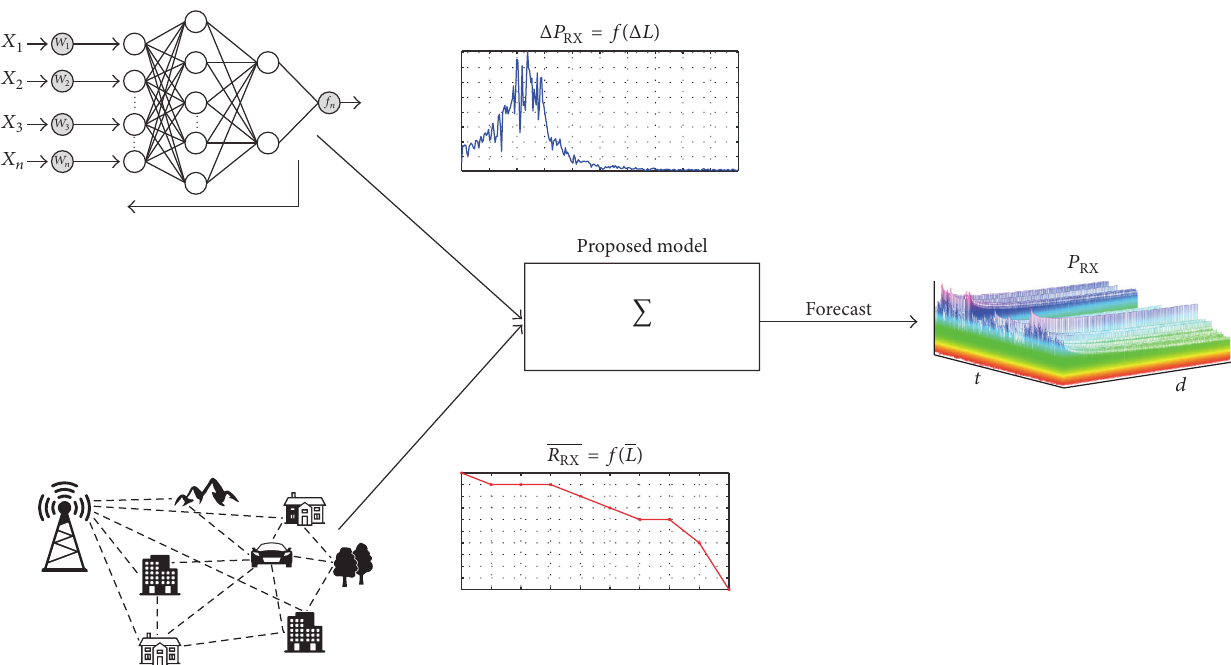
Figure 5: Scheme of the proposed model to forecast the spectrum opportunities.